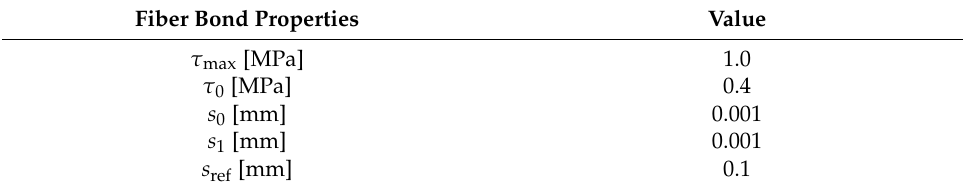
Table 5. Properties of the fiber-concrete bond evaluated from single fiber pullout tests.